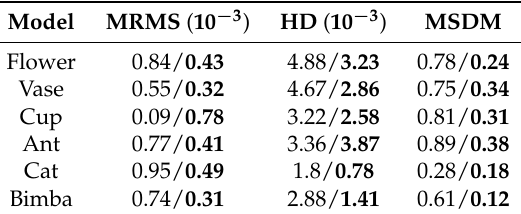
Table 4. Watermark imperceptibility without and with saliency measured in terms of MRMS, HD, and MSDM.